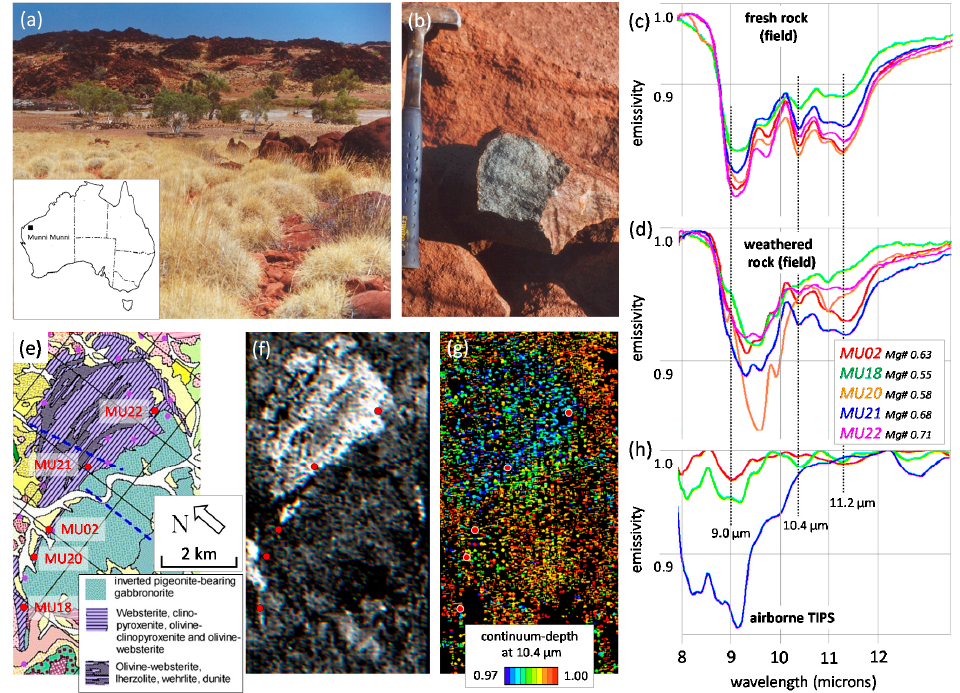
Figure 4. Airborne TIPS results from Munni Munni, Pilbara Craton, Western Australia. ( a ) Field photograph of websterite (foreground) and gabbro (background) outcrops. Note the extensive cover of Spinifex grass; ( b ) Close-up view of both natural weathered rock surfaces and a broken surface of diopside-rich websterite (locality MU21); ( c ) Field “MicroFTIR” emissivity spectra of diopside-bearing fresh rock samples. Field localities shown in ( e ); ( d ) Field “MicroFTIR” emissivity spectra of diopside-bearing weathered rock surfaces. Field localities shown in ( e ); ( e ) Published 100K geology of the Munni Munni area together with the locations of selected field samples of diopside-rich websterite. Scene center approximately − 21.1236° latitude 116.8420° longitude; ( f ) Interpolated, airborne TIPS processed partial unmixing “diopside” image (~10 m pixel) generated from the red spectrum in ( h ); ( g ) Interpolated airborne TIPS 10,400 nm (10.4 µ m) continuum-depth image (blue